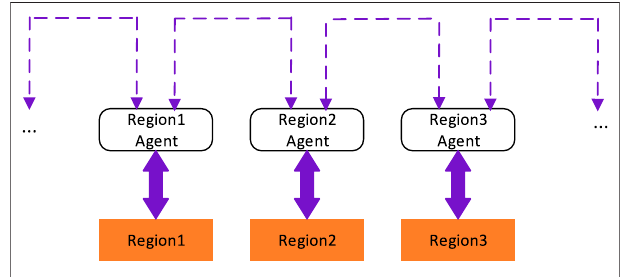
FIGURE 8 | schematic diagram of hybrid hierarchical control combining centralized and distributed control.